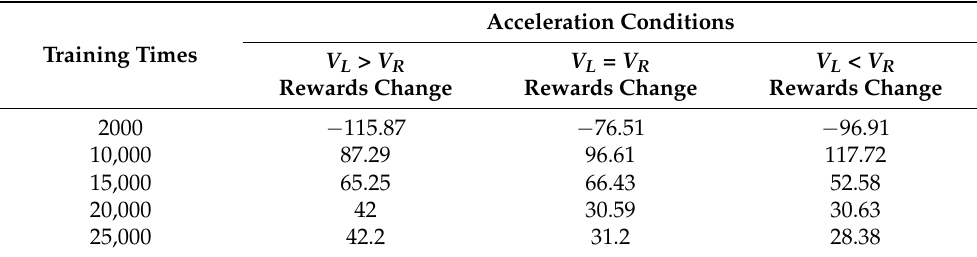
Table 3. Variation of reward function values for different acceleration conditions on both confron- tation sides of the detection–interference confrontation.